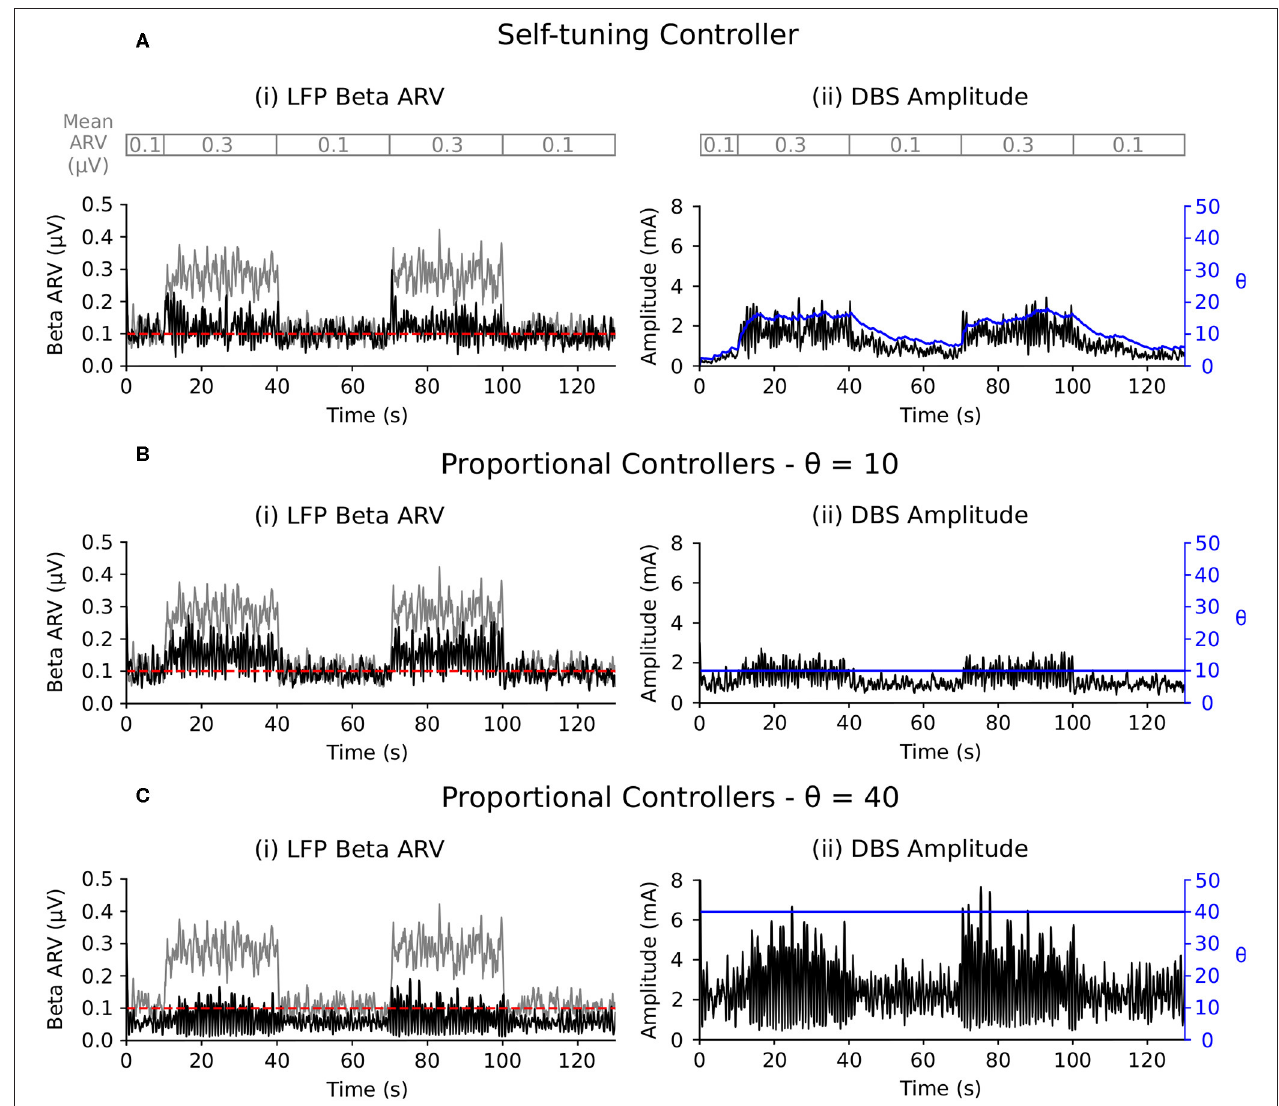
FIGURE 7 | Performance comparison of self-tuning and proportional controllers in response to background beta-band activity variations in the conductance-based model. The beta ARV target value was fixed to 0.1 µ V for the duration of the simulation while the background beta-band activity was modulated to be at its maximum value during the 10–40 and 70–100 s time periods and at its minimum value during the 0–10, 40–70, and 100–130 s time periods, respectively. The mean ARV of the background beta-band activity measured in the LFP when DBS was off is highlighted by the gray segmented bar at the top of the figure. Left panels illustrate the target value (dashed red), the beta ARV measured from the STN LFP when DBS was off (gray) or on (black), where the DBS amplitude was modulated by the corresponding controller. Right panels illustrate the time evolution of the DBS amplitude (black) and controller gain θ (blue) during simulation. (A) Self-tuning DBS controller with τ θ = 100 ms and σ = 0.00875. (B) Proportional controller with a fixed gain value of θ = 10. (C) Proportional controller with a fixed gain value of θ =